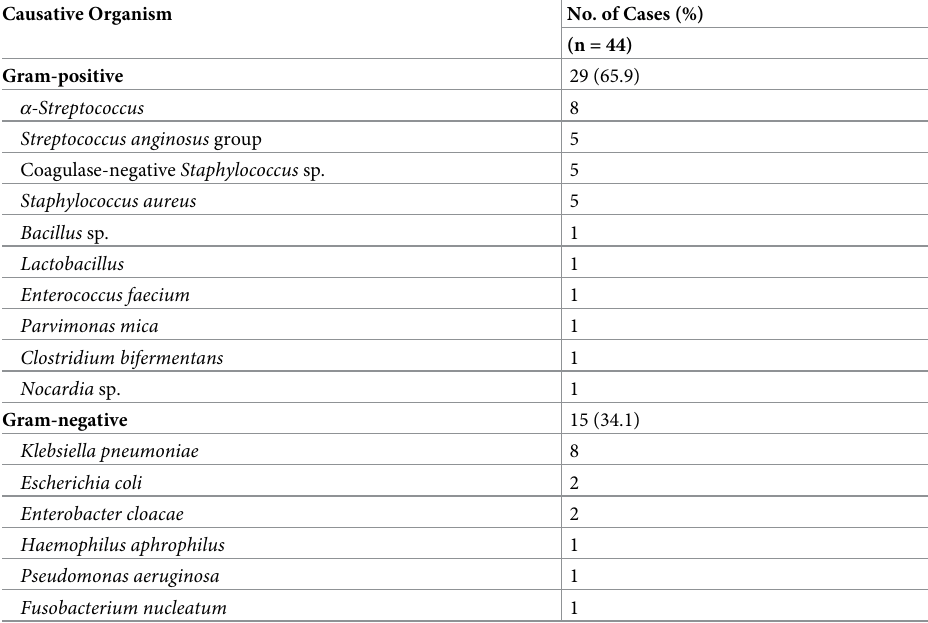
Table 3. Bacteria isolated from patients with culture-positive brain abscesses.